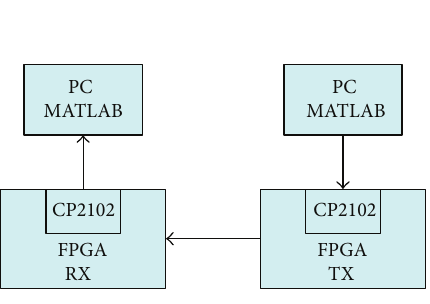
Figure 11: Diagram of the communication interface between the computer and the FPGA.